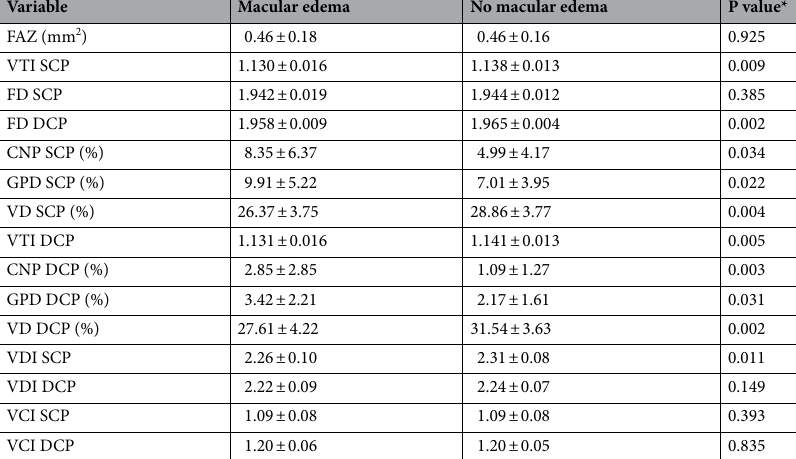
Table.2. Comparison of optical coherence tomography angiography (OCTA) metrics in eyes with and without diabetic macular edema based on univariate analysis. FAZ foveal avascular zone, VTI vascular tortuosity index, SCP superficial capillary plexus, DCP deep capillary plexus, FD fractal dimension, CNP capillary non perfusion, GPD geometric perfusion deficit, VD vessel density, VDI vessel diameter index, VCI vascular complexity index. *Based on GEE model after adjusting for the stage of diabetic retinopathy.